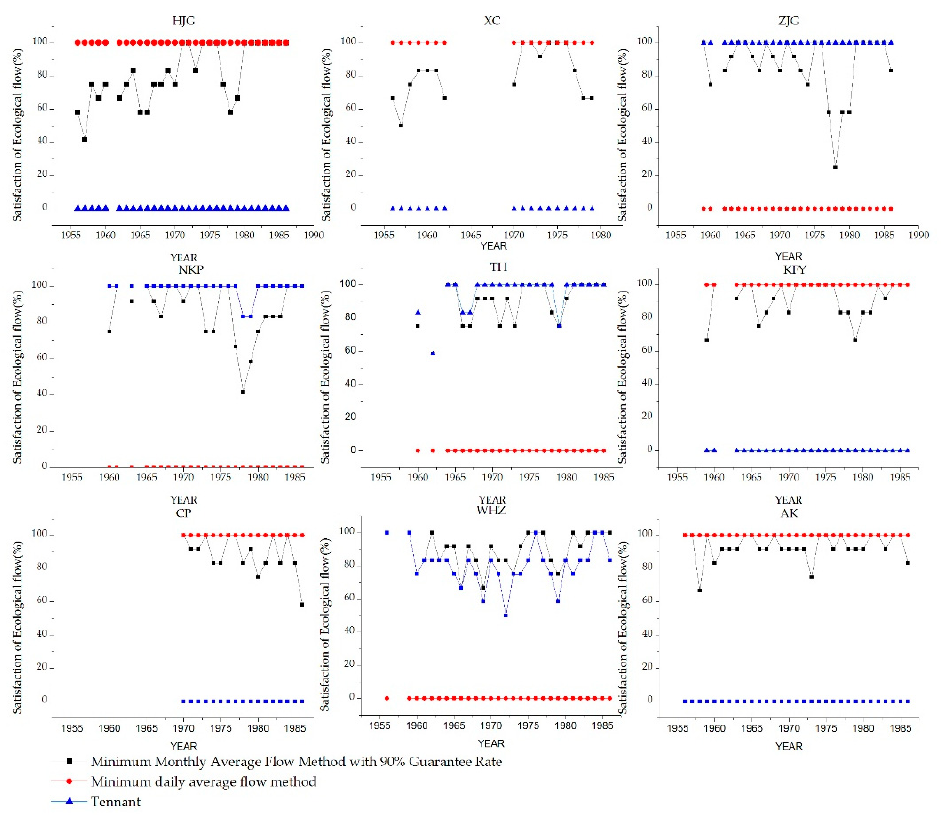
Figure 5. Ecological satisfaction degrees of different e-flow methods at hydrological stations in the Han River basin.